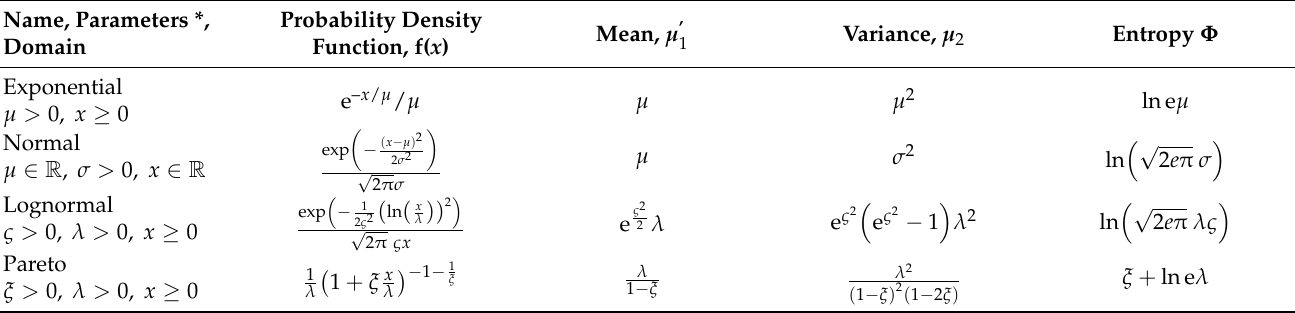
Table 2. Main characteristics of the distribution functions used in the illustrations.